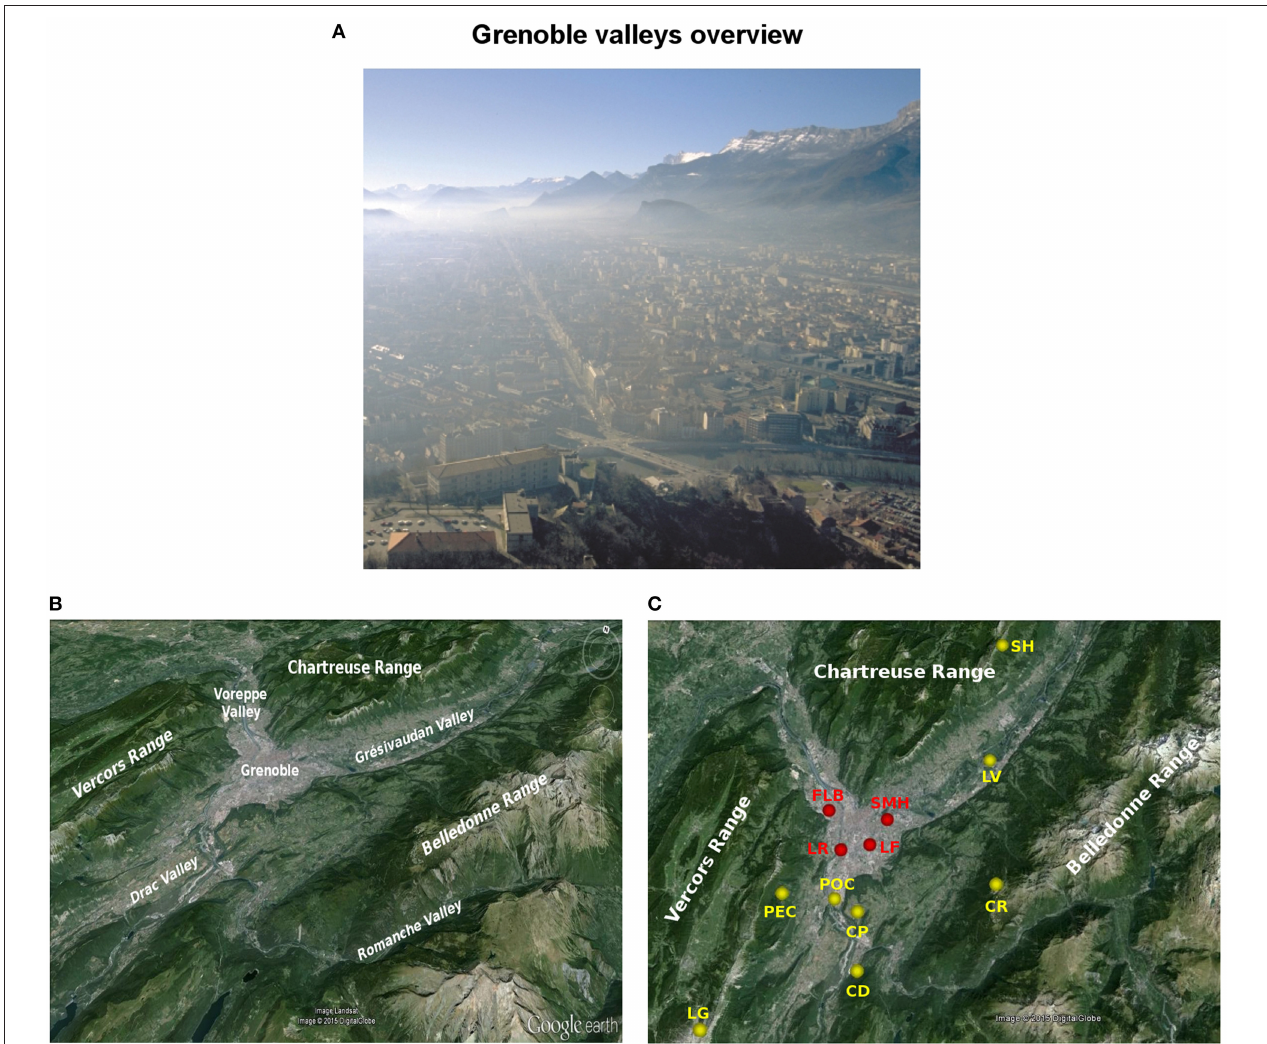
FIGURE 1 | (A) Particulate Matter pollution during wintertime inversions over Grenoble (Photography: courtesy of Eric Chaxel). (B) View of the mountain ranges and Grenoble valleys discussed in the paper. (C) Locations of the ground-based Automatic Weather Stations (yellow) and air-quality stations (red, not used in the present study); the acronyms are defined in Table 1 . Extracted and adapted from Largeron and Staquet (2016) with background maps taken from Google Earth.